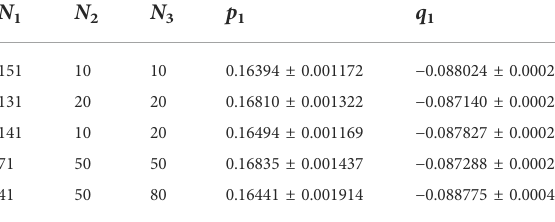
TABLE 1 Corner and edge contribution for S 1 of a fi nite disk in an edge reconstructedpattern.We fi xthetotalnumberoforbitals N = N 1 + N N 2 + 3 = 171 and consider several combinations of different { shows that the p 1 and q 1 are very robust and consistent with the previous unreconstructed